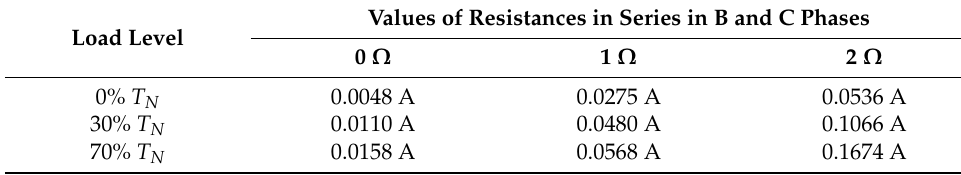
Table 4. Simulation data of motor negative sequence current at 10 Hz.